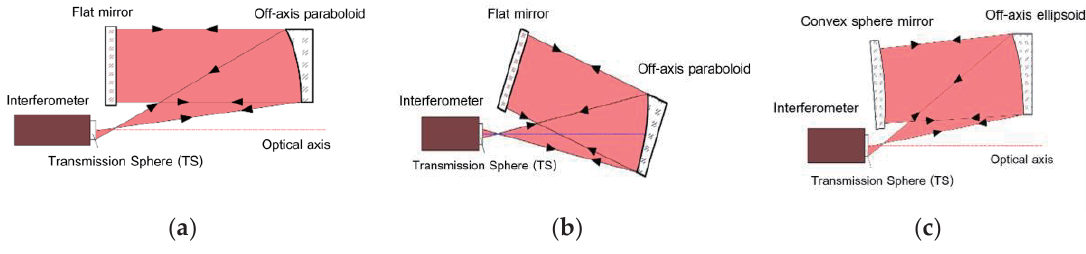
Figure 1. Schematic diagram of auto-collimation: ( a ) o ff -axis paraboloid located at o ff -axis; ( b ) o ff -axis paraboloid located at on-axis; ( c ) o ff -axis ellipsoid located at o ff